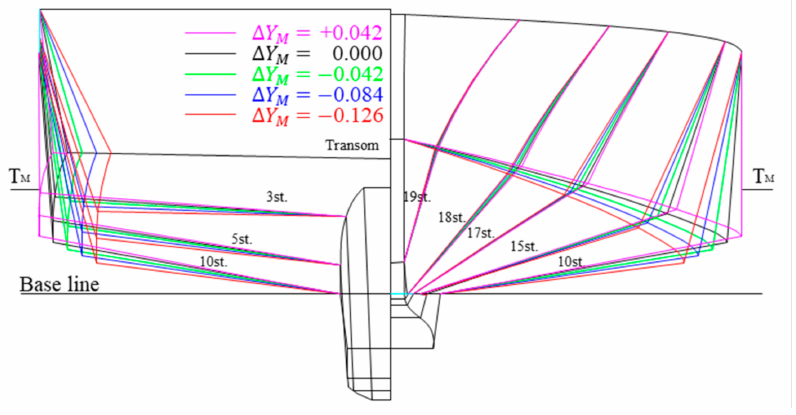
Figure 6. Comparison of initial and varied hull forms.